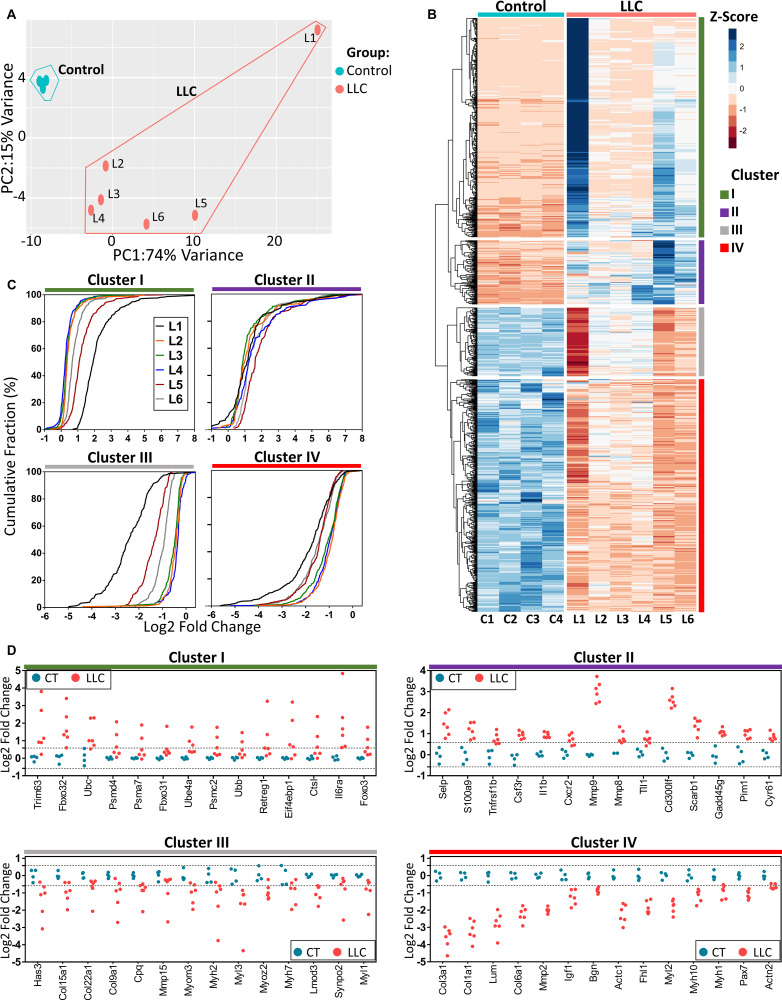
Comprehensive transcriptome characterization of muscle wasting revealed differential gene expression stability in cancer cachexia. (A) Principal component analysis of the gene expression data of control and tumor-bearing mice (LLC) groups. The percentage of the variance of each principal component (PC1 and PC2) for control (C1–C4) and LLC samples (L1–L6). (B) Heatmap of 1008 Z-score normalized differentially expressed genes of control (C1–C4) and LLC samples (L1–L6) by unsupervised hierarchical clustering analysis identified the clusters I (n = 386), II (n = 101), III (n = 157), and IV (n = 364). Down-regulated and up-regulated genes with absolute values of fold-change > 1.5 and FDR < 0.05 (Wald statistics) are shown in red and blue dots, respectively. (C) Cumulative frequency distribution of the differentially expressed genes (log2-fold change, x-axis) for LLC (L1–L6) vs. control samples, indicated as a percentage (%, y-axis) for each cluster (I to IV) identified in panel (B). (D) Dot plots of differentially expressed genes selected for each cluster (I to IV) identified in panel (B) to demonstrate the range in expression variability across genes within LLC samples. Light blue and pink dots represent control and LLC samples, respectively. These genes were identified as either previously associated with muscle atrophy in cachexia or that we hypothesized may be associated with muscle atrophy, based on the literature. The threshold for up- and down-regulated (|fold change| ≥ 1.5) are indicated by dashed lines.